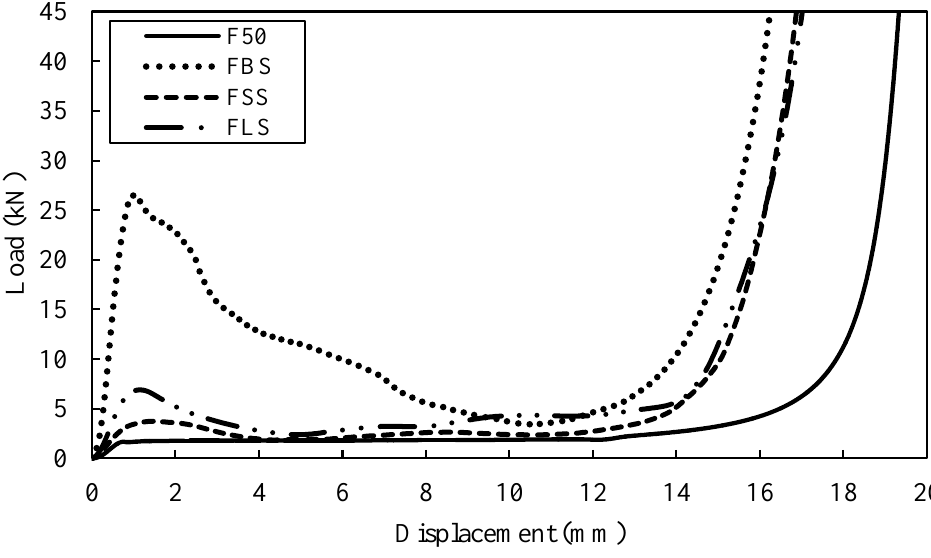
Figure 7. Load-displacement curve for F50 reinforced with different type of single tubes.